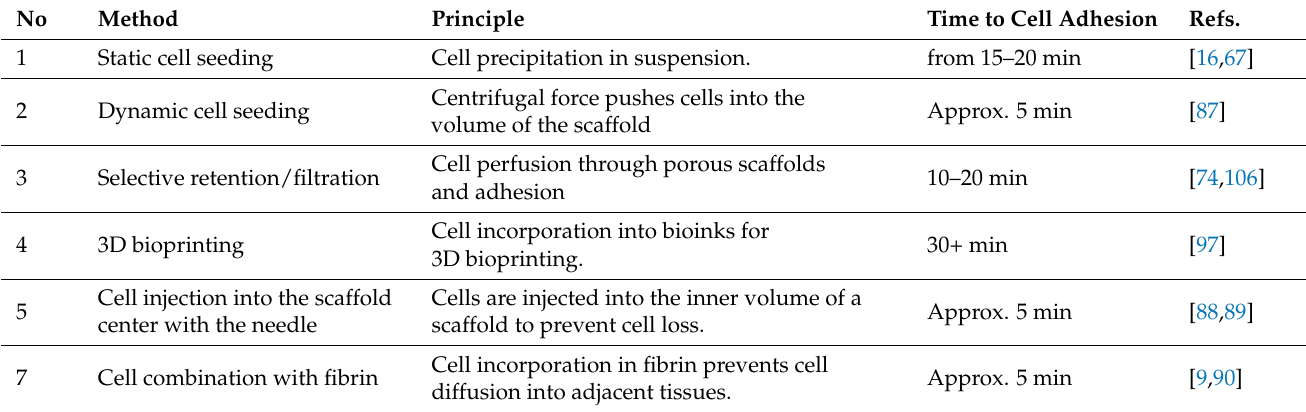
Table 2. Methods that can be applied for intraoperative cell